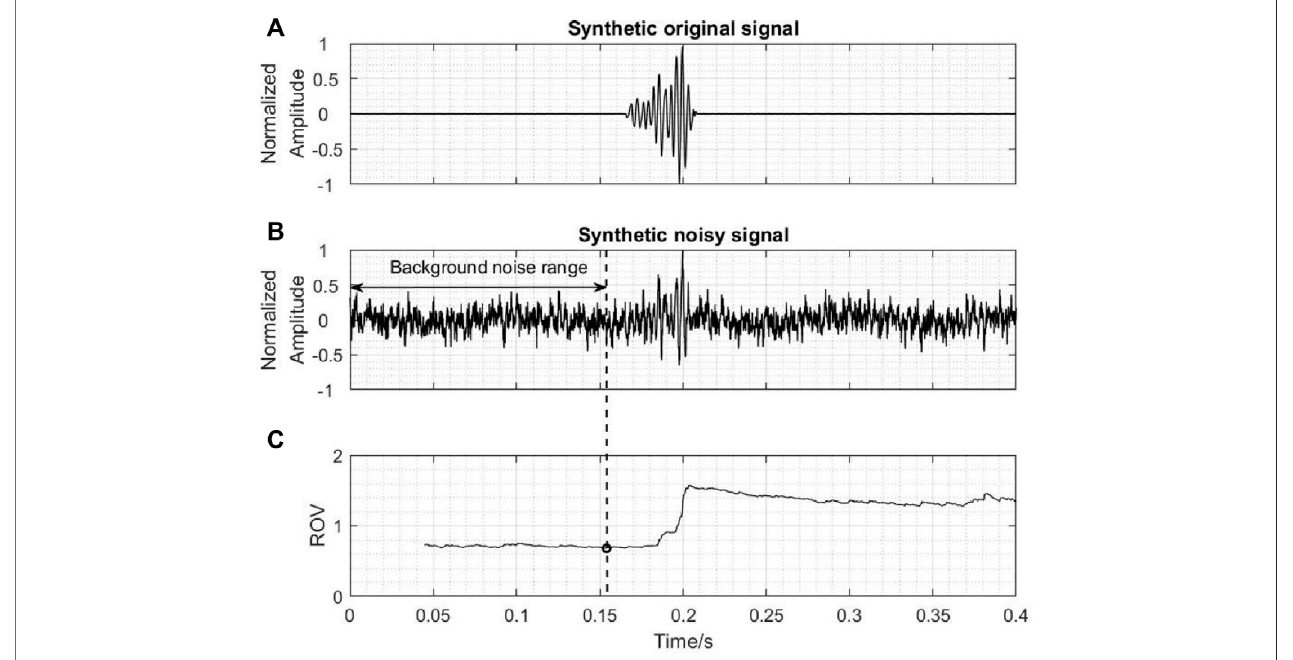
FIGURE 2 | The range of background noise estimation via ROV curve. (A) The waveform of the original seismic signal. (B) Synthetic seismic signal with noise. (C) ROV curve of the synthetic noisy signal, where a black circle indicates the minimum of ROV.